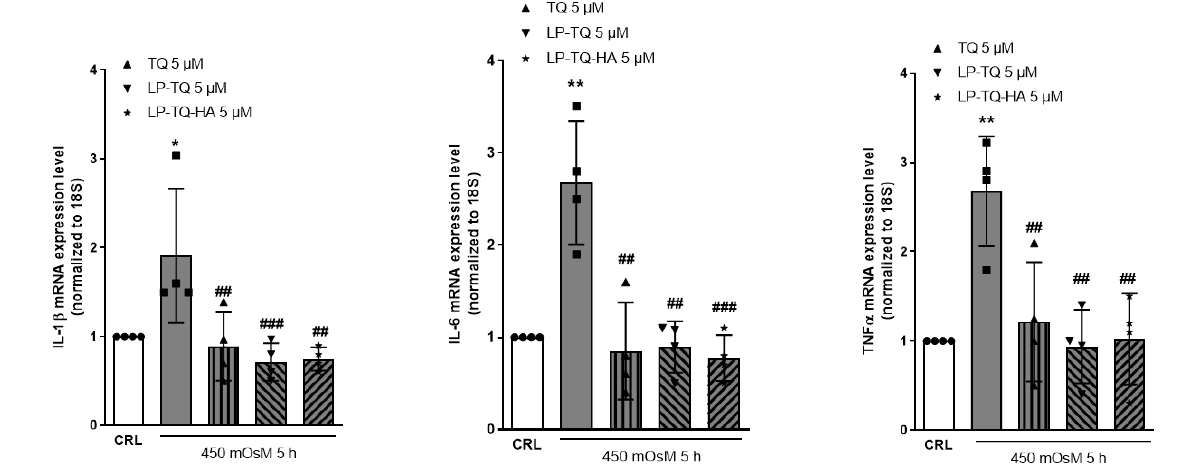
Figure 2. The mRNA levels of IL-1 β , Il-6 and TNF α in HCE-2 cells exposed to hyperosmotic media and treated with TQ, LP-TQ and PL-TQ-HA. Dot blots show the results of four experiments. * p < 0.05 and ** p < 0.01 vs. CRL; ## p < 0.01 and ### p < 0.01 vs. hyperosmolarity (ANOVA + Tukey’s w-test).